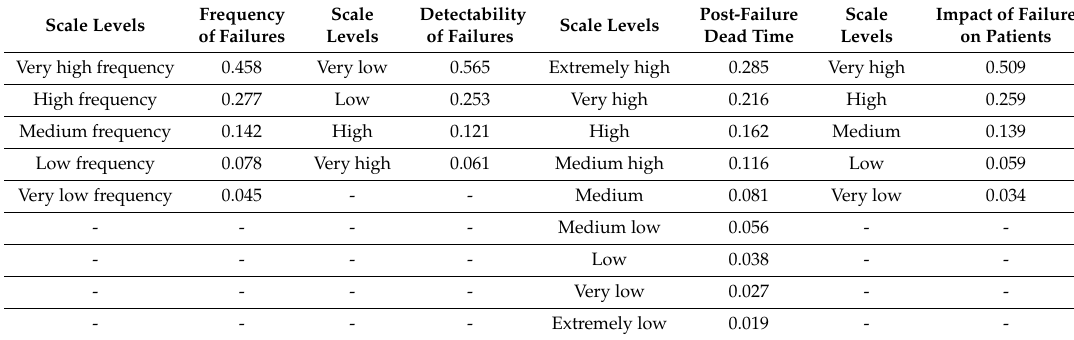
Table 15. Weightings of the scale levels of the descriptors of Failures.